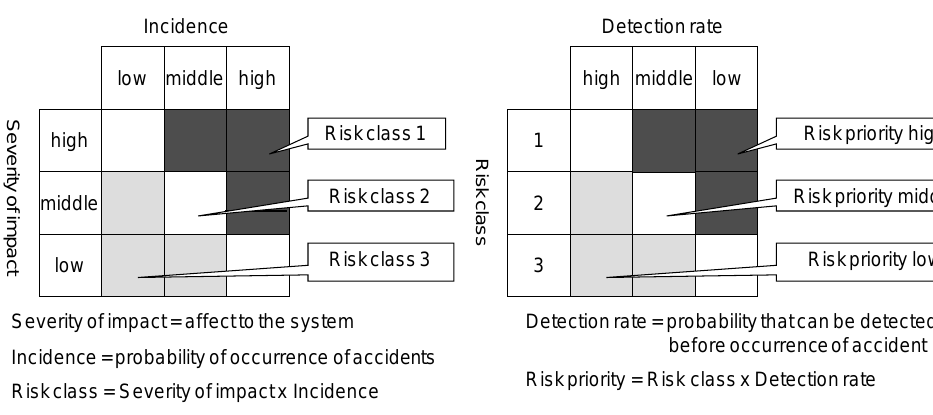
Figure 3. Risk evaluation matrix.